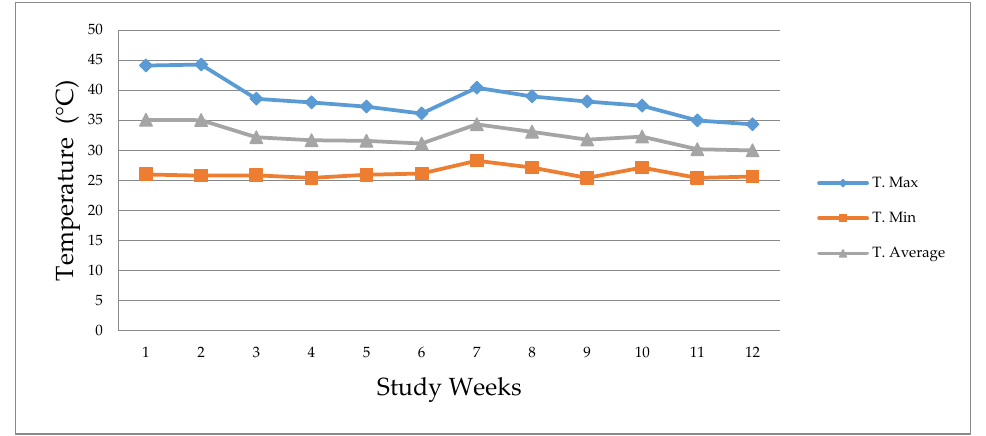
Figure 1. Maximum temperature (T. Max), minimum temperature (T. Min), and average temperature (T. Average).